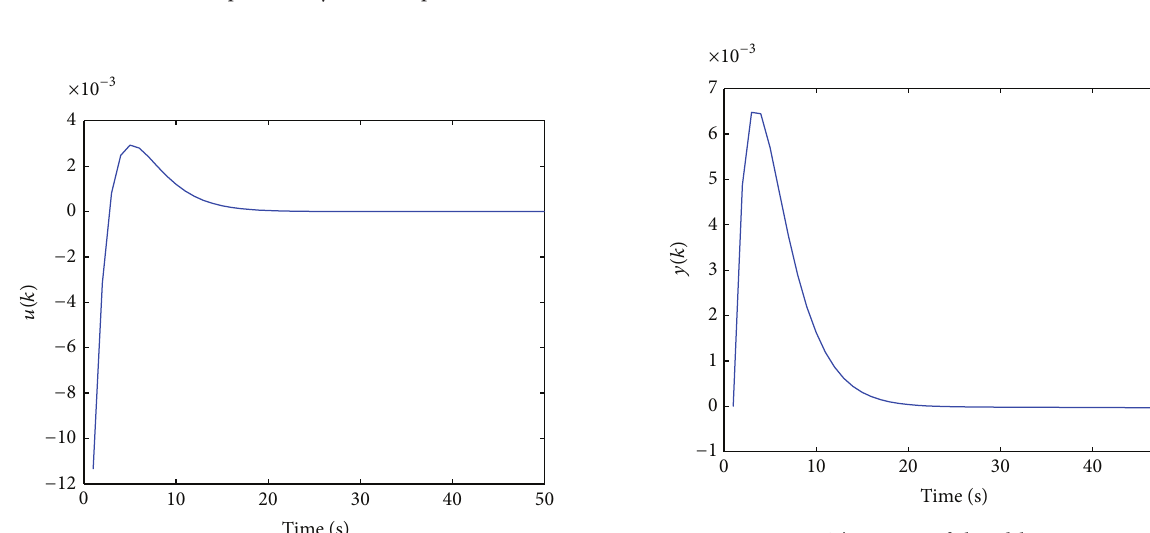
Figure 8: The state response of dynamic output controller.